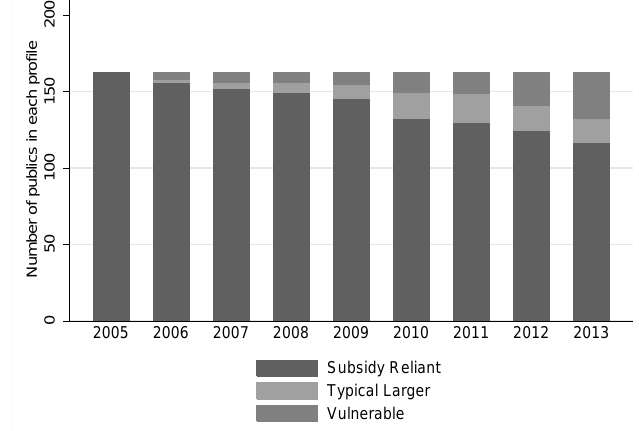
Figure 5. Change over time in percentage of public institutions that were Subsidy Reliant in